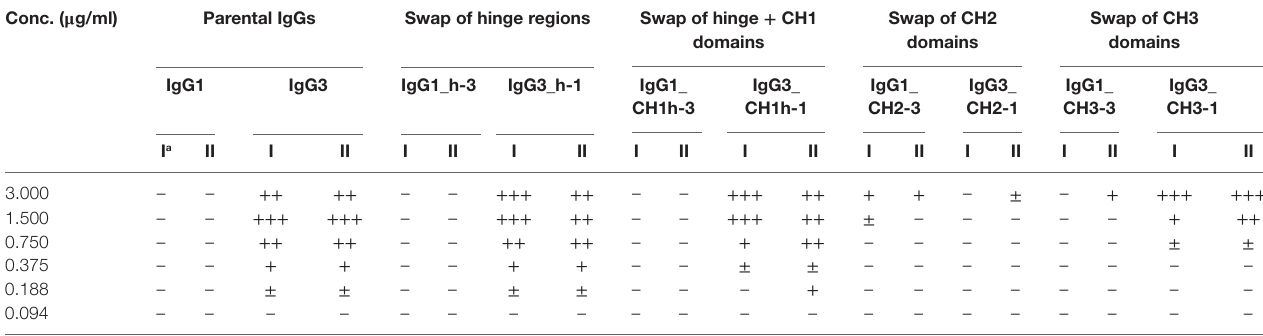
TaBle 3 | Scores of hemagglutination induced by O10